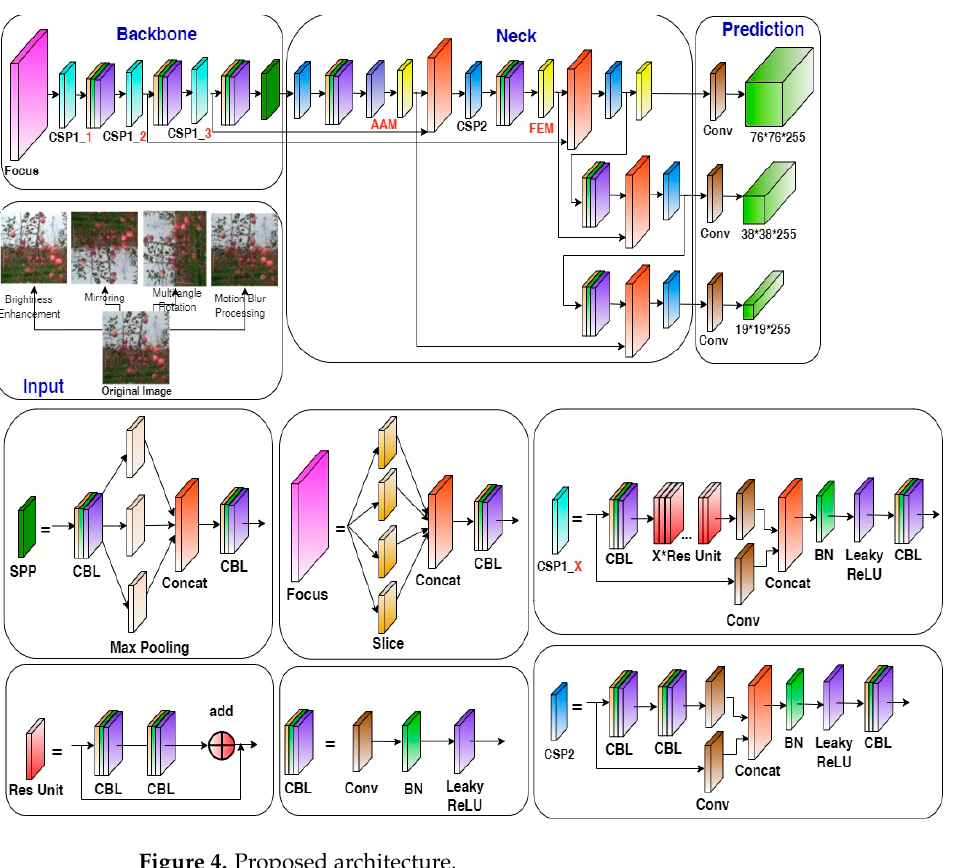
Figure 4. Proposed architecture.